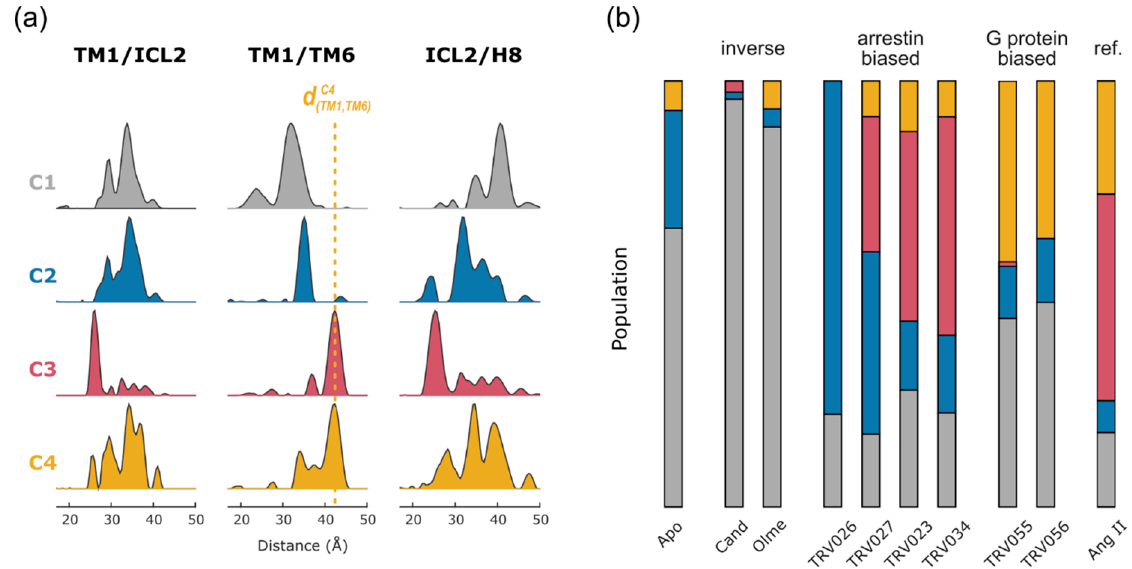
Figure 3. NNMF analysis. ( a ) NNMF analysis of AT1R DEER data reveals four major conformational states C1–C4 (columns of matrix C ). Residual multimodality in each conformation suggests Table 1. C4 under the various ligand conditions. Bias of different agonists can be identified by the population of C2 , C3 and C4